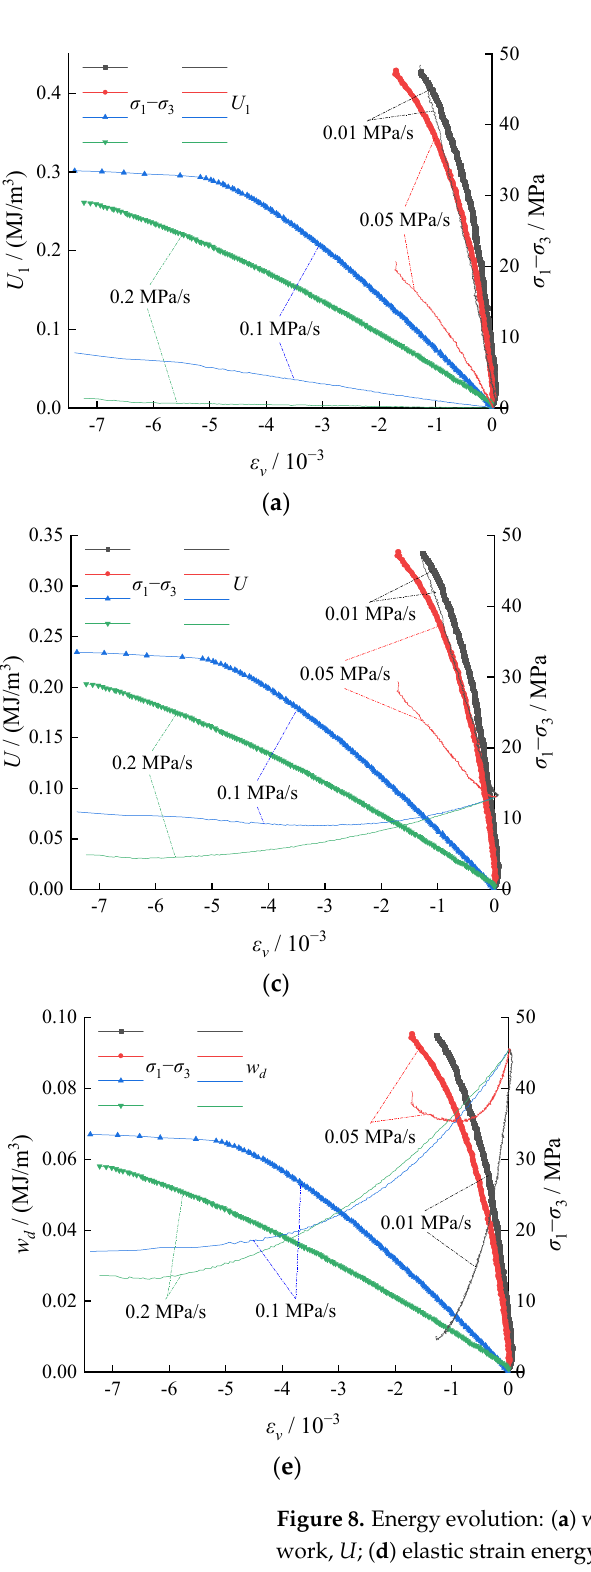
( b ) Figure 9. Elastic energy conversion rate: ( a ) conversion rate of elastic energy–volumetric strain evo- lution curve and ( b ) conversion rate of elastic strain and unloading rate.